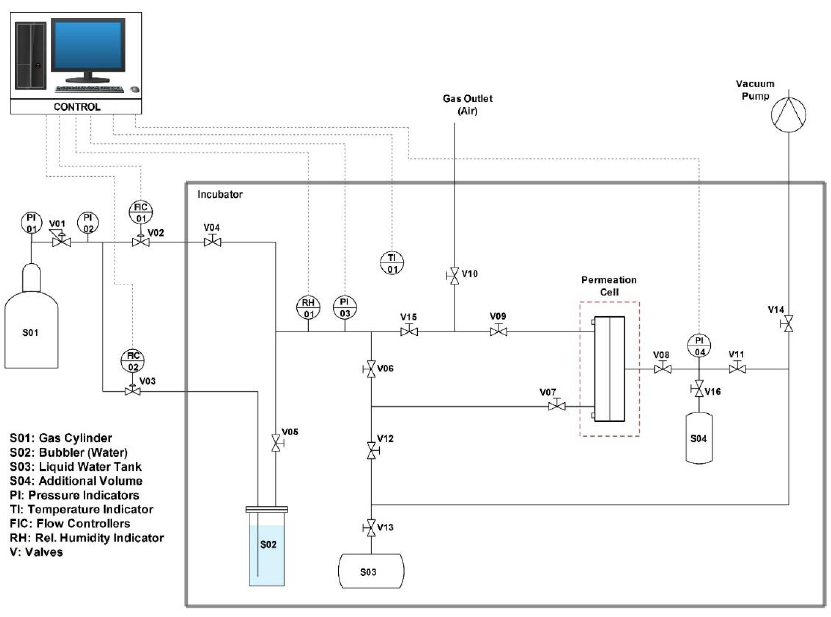
Figure 4. Layout of humid permeation setup.